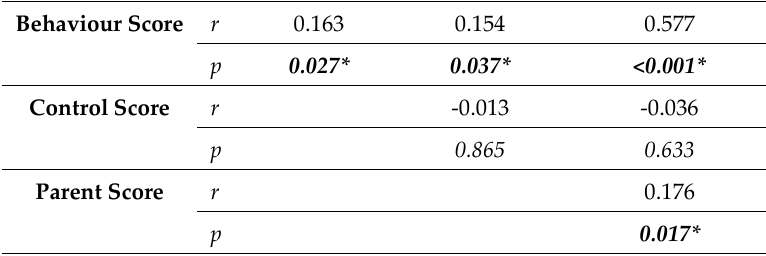
Table 8: Correlation values between scale